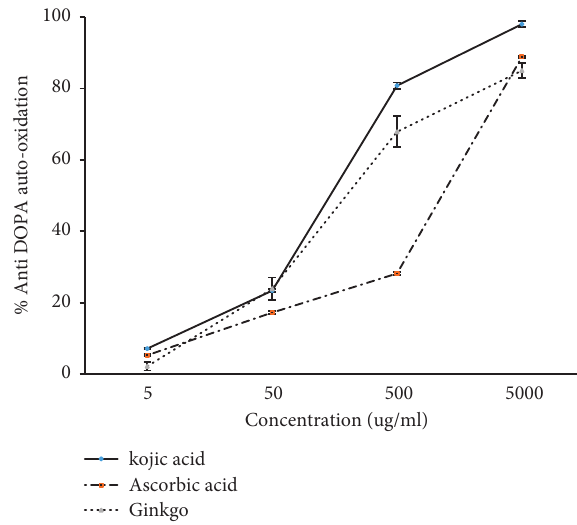
Figure 3: Anti-DOPA auto-oxidation of G. biloba tea extract with different concentrations compared with that of positive controls kojic acid and ascorbic acid (mean ± SD, n �